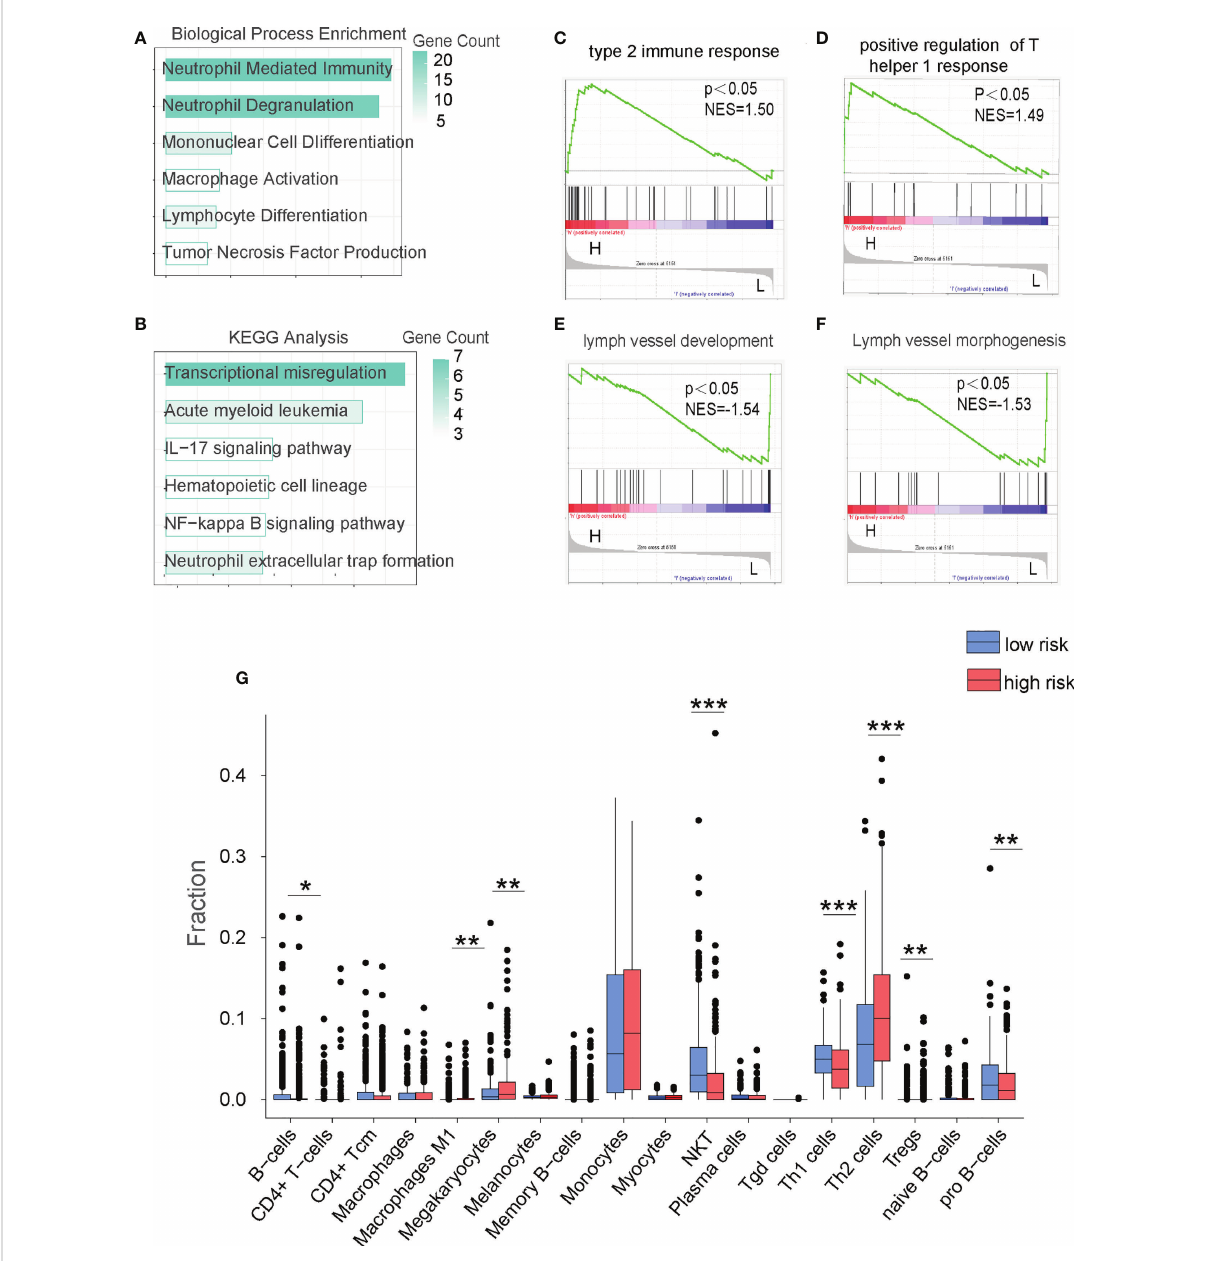
FIGURE 4 The FAM formula identi fi es alterations in the immune microenvironment of AML patients in the TC database. (A) GO analysis of the low risk (LR) and high risk (HR) cohorts in the TC. (B) KEGG network analysis of the LR and HR cohorts in the TC. (C – F) GSEA analysis of LR and HR cohorts in the TC. (G) Analyze the immune cell populations of the LR and HR patients using the XCELL algorithm in the TC. *p < 0.05,**p < 0.01, ***p <